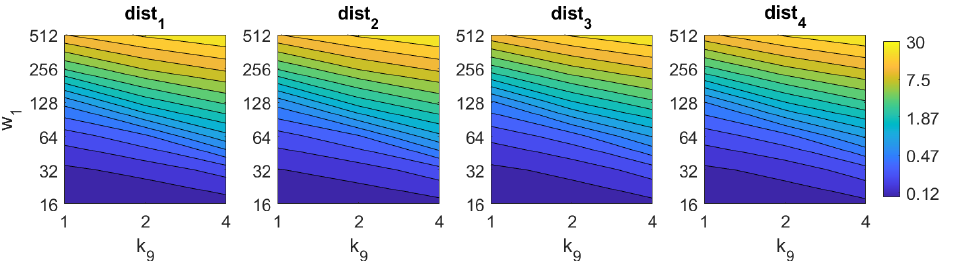
Figure 15. Gist image retrieval problem. Computational time.